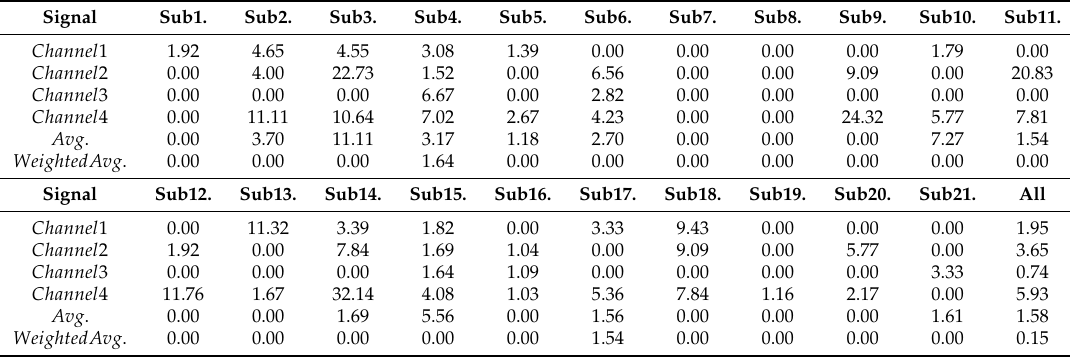
Table 3. Failed detection rate (%) of each subject for slow horizontal movement. Signal Sub1. Sub2. Sub3. Sub4.